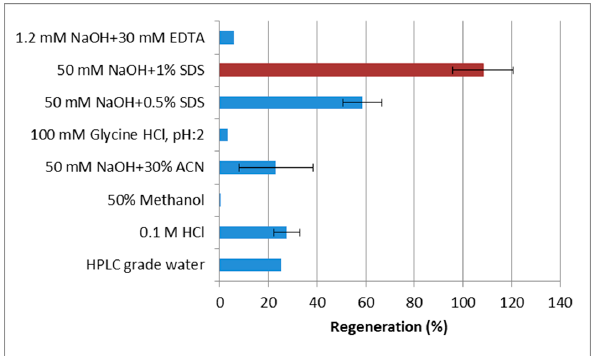
Figure 4. Regeneration of AFB1 immobilized sensor surface after MAM-D12E2 application using different solutions. Results are presented as the percentage of the antibody recovered from the surface, calculated with binding and regeneration frequency shifts.